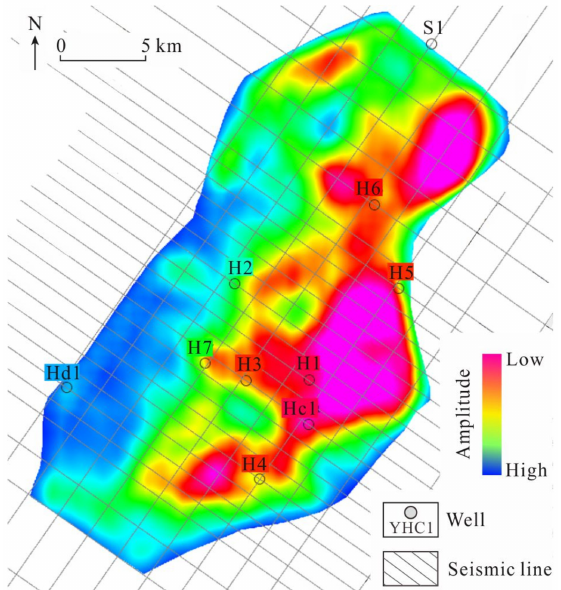
Figure 9. Map view of fault-lithologic traps in K 1 b 2 in the Hari